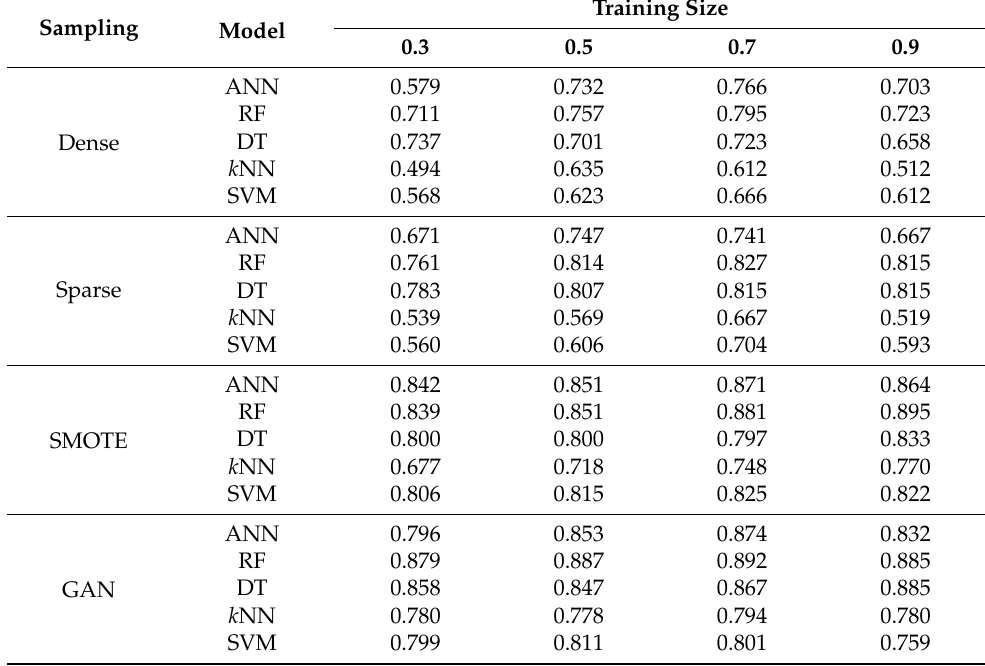
Table A6. Assessment of models with different sampling methods based on Kappa Index.